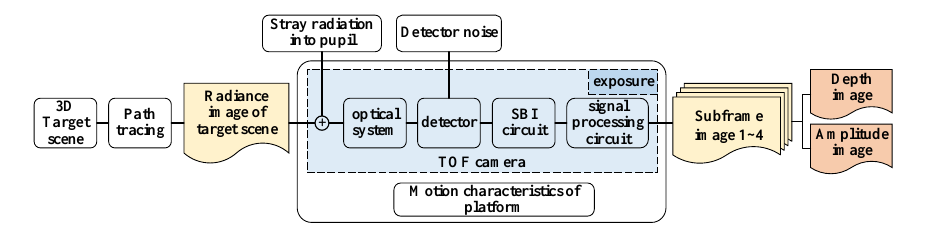
Figure 9. AMCW TOF camera imaging simulation model.